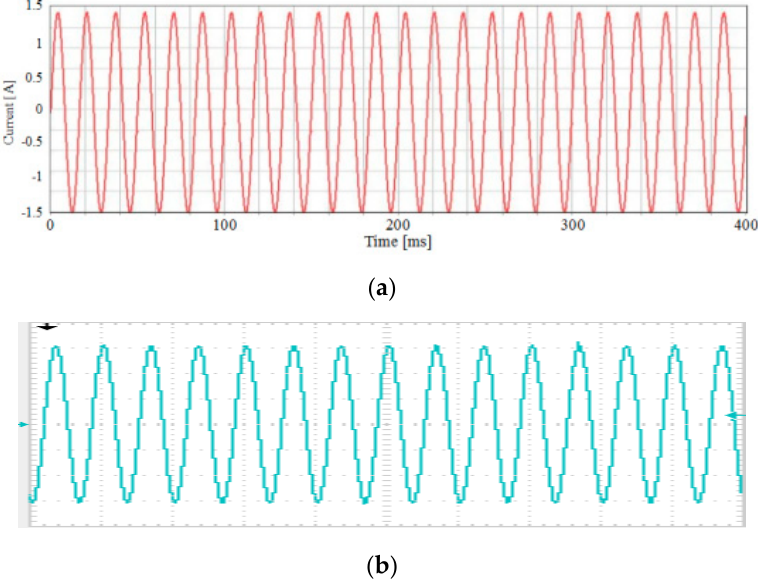
Figure 11. Customized waveform output test: ( a ) Simulator input waveform; ( b ) Simulator output waveform (voltage: 200 mV/div, time: 25 ms/div).